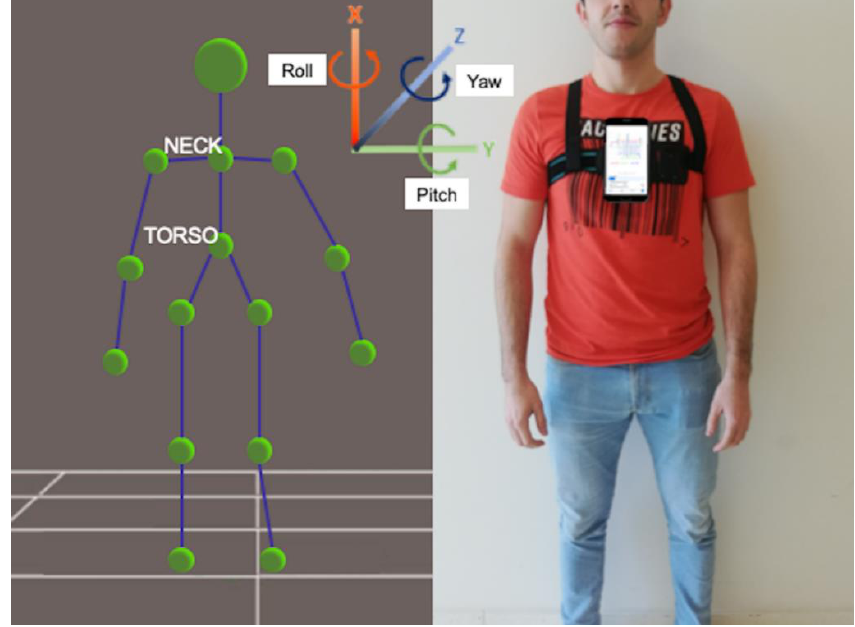
Figure 2. Joints information collected by the camera and 3D reference system of the camera and the inertial measurement unit.